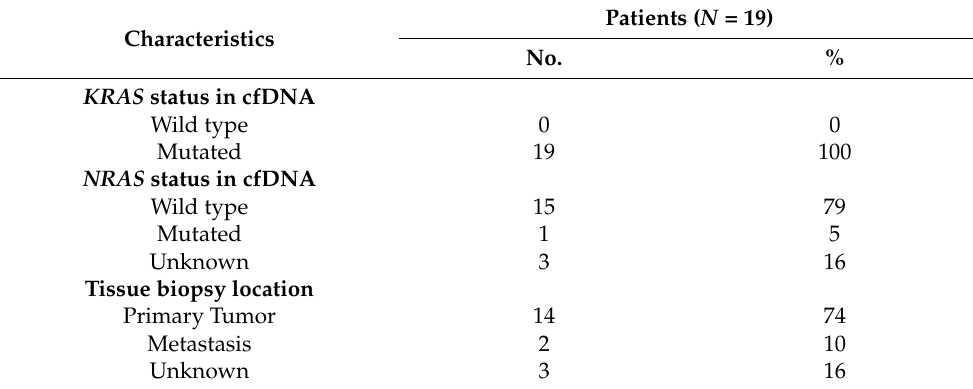
Figure 1. Overview of the variant distribution detected in cfDNA of CRC patients by TST170. ( A ) Global distribution of SNVs and indels in mCRC patients. ( B ) Distribution of SNVs and indels in mCRC patients according to variant type. The term “CRCtotal” represents the mean for all CRC patients analyzed of total variants detected per patient. 3.3. Identification of Cancer-Associated Variants with Clinical Significance in cfDNA of mCRC Patients One of the key challenges in precision oncology is the identification and pathological interpretation of cancer-associated variants detected by sequencing [20]. Thus, to evaluate the pathogenicity of the variants detected in cfDNA by TST170, we used the somatic op- tion of the in silico pipeline from VarSome Clinical, which follows the four-tier system recommended by the American College of Medical Genetics and Genomics (ACMG) and the Association for Molecular Pathology (AMP). This system classifies somatic variants into four categories based on their clinical impact: tier I, variants with strong clinical sig- nificance; tier II, variants with potential clinical significance; tier III, variants with un- known clinical significance; and tier IV, benign or likely benign variants [20]. Using this approach, we observed that 0.4% of all the variants detected in cfDNA of our cohort by TST170 were classified as tier I and 1.5% as tier II, while 3.8% were considered tier III and 94.3% were tier IV (Figure S1). Importantly, we frequently detected tier I variants in KRAS (79%, 15/19) and PIK3CA (26%, 5/19) genes of our CRC cohort. In addition, tier II variants were detected in another 27 cancer-relevant genes, including APC , which was the gene with the most tier II variants identified (Figure 2).